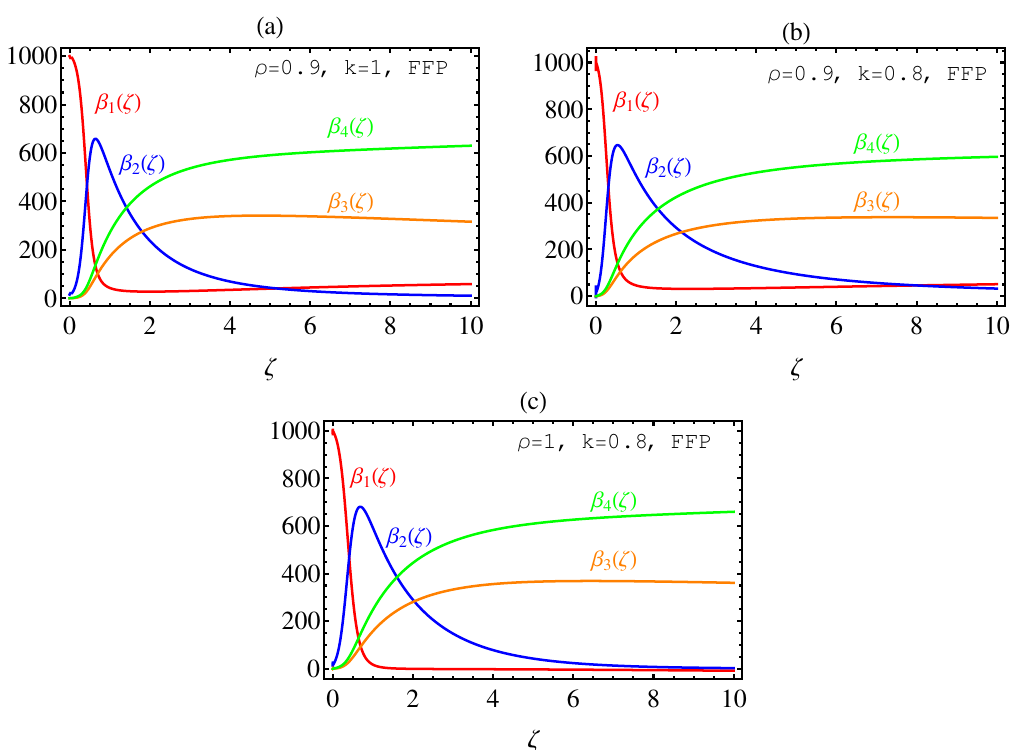
Figure 2. Graph of the numerical solutions based on FFP for ( a ) ρ = 0.9, k = 1, ( b ) ρ = 0.9, k = 0.8 and ( c ) ρ = 1, k = 0.8, respectively, with λ = 0.01, s = 0.02, δ = 0.6, α = 0.4 and β = 0.01, N = 1000, h = 0.02 and the following initial conditions: β 1 ( 0 ) = 1000, β 2 ( 0 ) = 15, β 3 ( 0 ) = 0and β 4 ( 0 ) = 0.